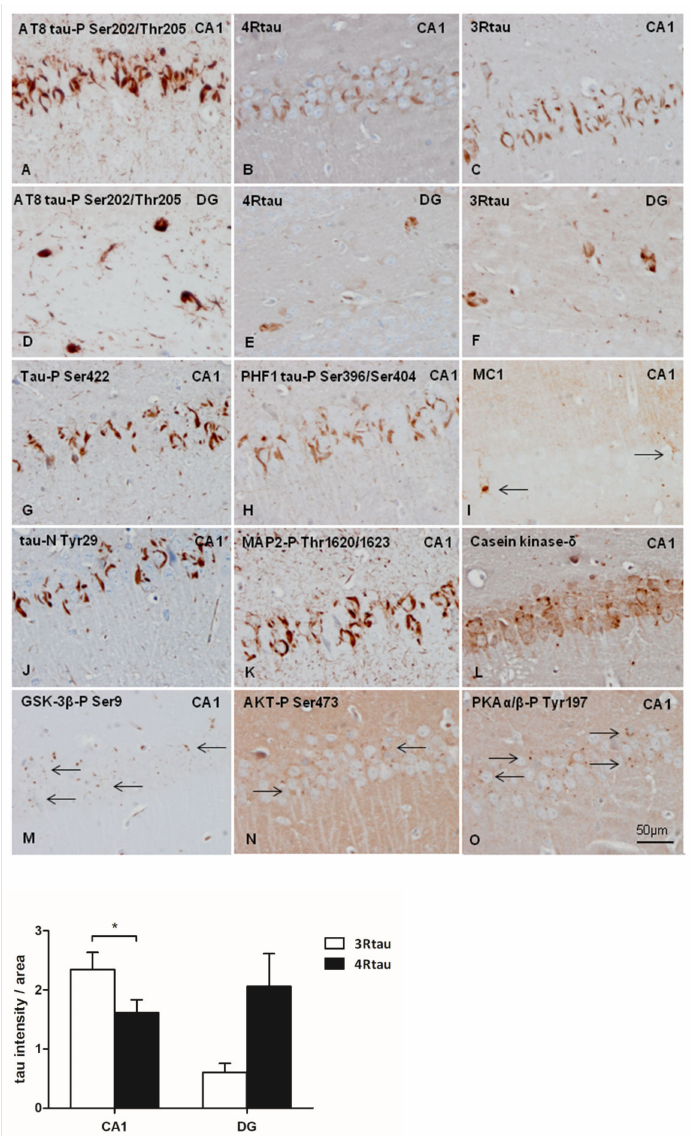
Figure 5. hTau transgenic mice unilaterally inoculated in the hippocampus with sarkosyl-insoluble fractions from AD homogenates at the age of six months and killed at the age of nine months show abundant abnormal deposits in the CA1 region of the hippocampus ( CA1 ) and dentate gyrus ( DG ). AT8-immunoreactive deposits are seen in CA1 region ( A ), and dentate gyrus and hilus ( D ). Tau deposits are stained with anti-4Rtau antibodies ( B , E ), and more strongly with anti-3Rtau antibodies ( C , F ). Phospho-tau deposits in hTau transgenic mice are dense and flame-shaped, reminiscent of neurofibrillary tangles. Immunoreactivity to tau-P Ser422, PHF1, MAP2-P, and tau-N Tyr29 is strongly positive ( G , H , K and J , respectively). MC1 immunoreactivity is restricted to a few neurons ( I ); in this field, one neuron has small granular deposits (right arrow) and the other a dense round inclusion (left arrow). CK1- δ ( L ), GSK-3 β -P Ser9 ( M ), AKT-P Ser473 ( N ), and PKA α / β -P Tyr197 ( O ) granular immunoreactivity (arrows) appears in affected neurons in inoculated hTau mice. Sections are consecutive and obtained from the same inoculated hTau mouse. Paraffin sections slightly counterstained with haematoxylin, bar = 50 µ m. The graph shows quantitative densitometry for anti-3Rtau and anti-4Rtau staining expressed as a percentage of arbitrary units per area in CA1 and dentate gyrus (DG) regions in inoculated hTau mice surviving six months after injection. Results were analyzed with Student’s t -test. Differences between anti-3Rtau and anti-4Rtau staining within the same region in consecutive slices were considered statistically significant at * p <